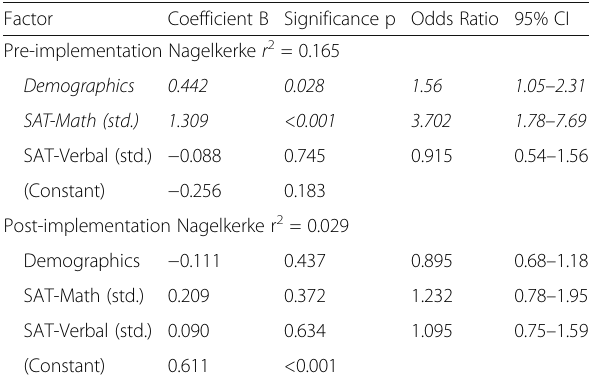
Table 8 Logistic regression coefficients with dependent variable gateway course success (B – or greater). Pre-implementation, demographic factor and SAT-Math scores were significantly correlated with gateway course success. Post-implementation, SAT-Math scores are no longer significant predictors of gateway